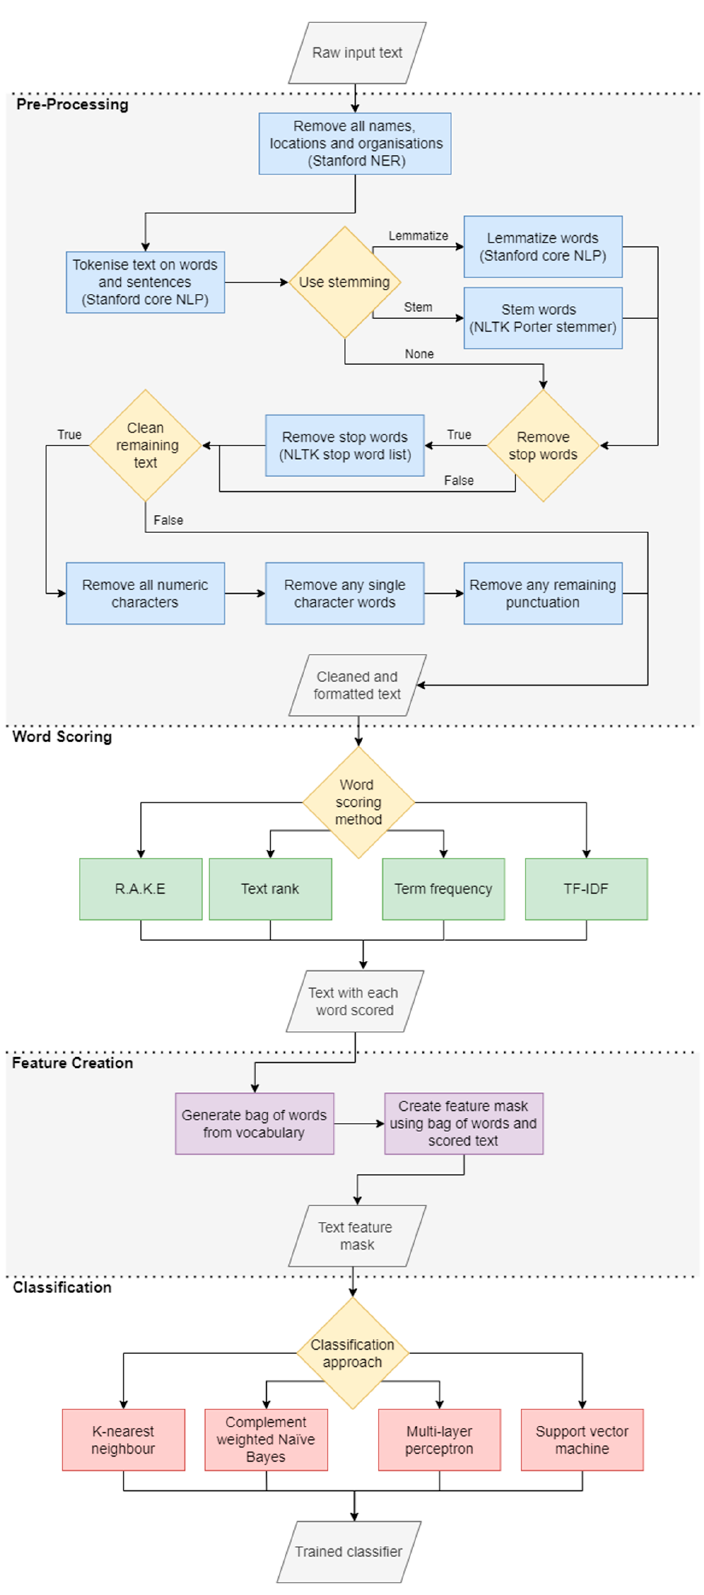
Figure 3. Representation of the text processing and classification pipeline, showing each stage described in Section 2. Rhomboids represent data, rectangles represent processes and diamonds represent decisions which can be made modified within the software parameters.